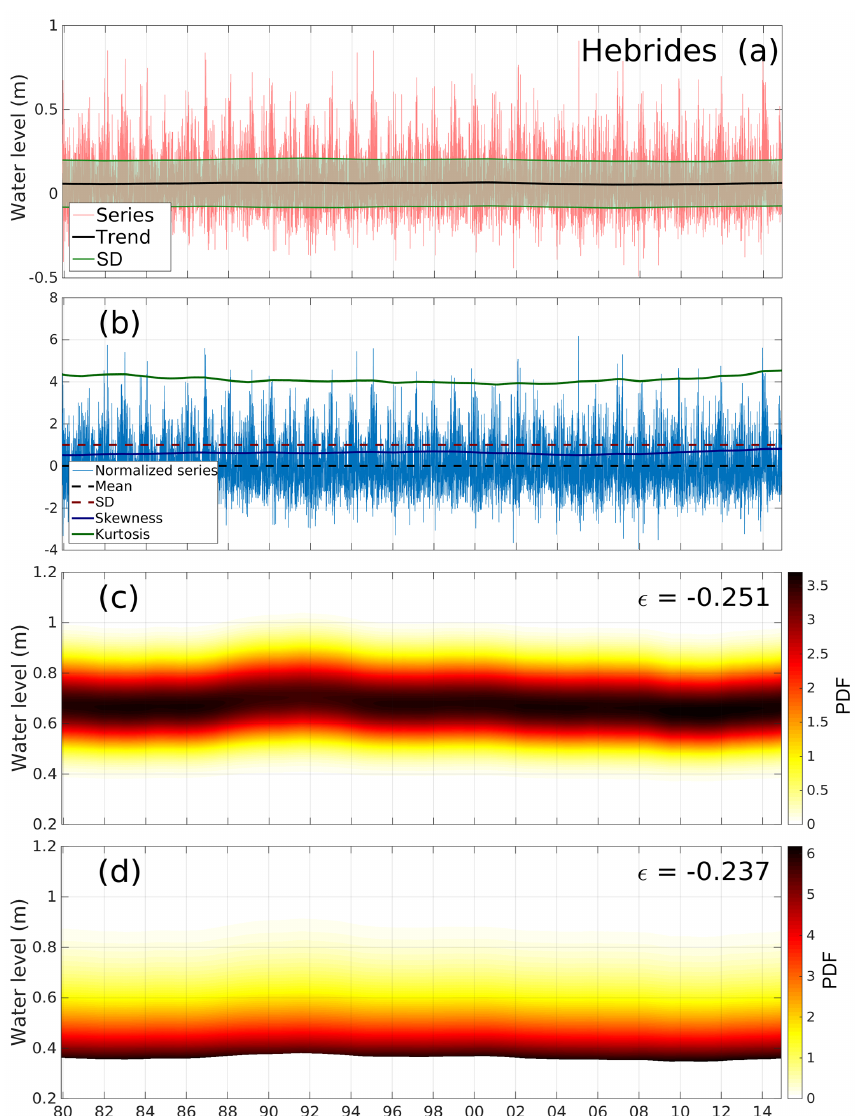
Figure 6. Long-term analysis of the residual water levels modeled at the Hebrides Islands: (a) series, its trend, and standard deviation; (b) the normalized series with higher order statistical indicators; (c) non-stationary GEV of annual maxima; (d) non-stationary GPD of annual peaks. In (c) and (d) the values of the shape parameter ε best fitted for the GEV and GPD distributions are reported.